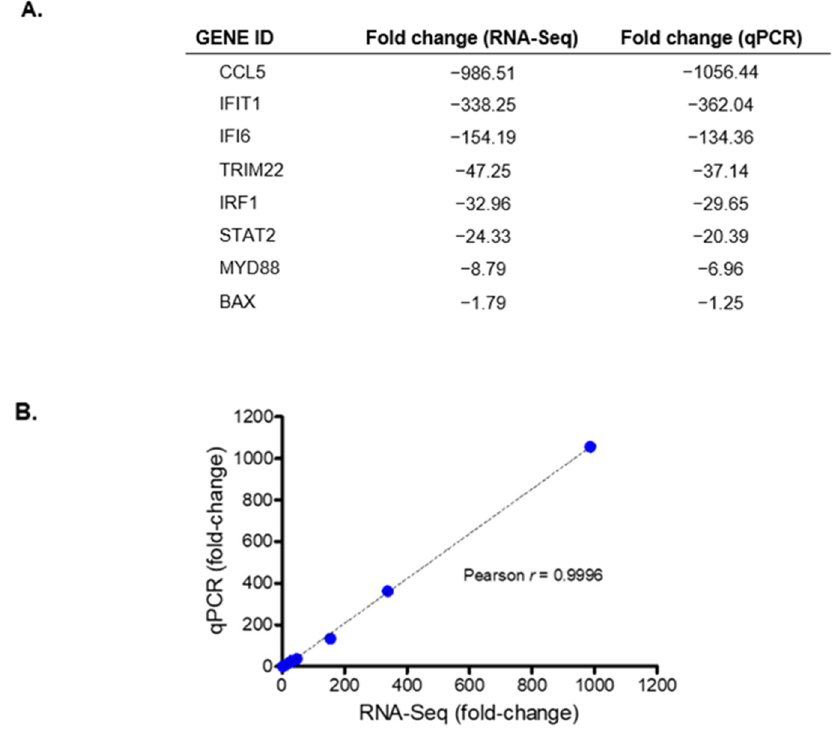
Figure 3. Validation of RNA-Sequencing. ( A ) Shown is the fold change of select genes that were generated from RNA-seq and qPCR for DENV capsid-expressing cells. ( B ) The fold-change obtained from RNA-Seq and qPCR were plotted with a line of best fit.